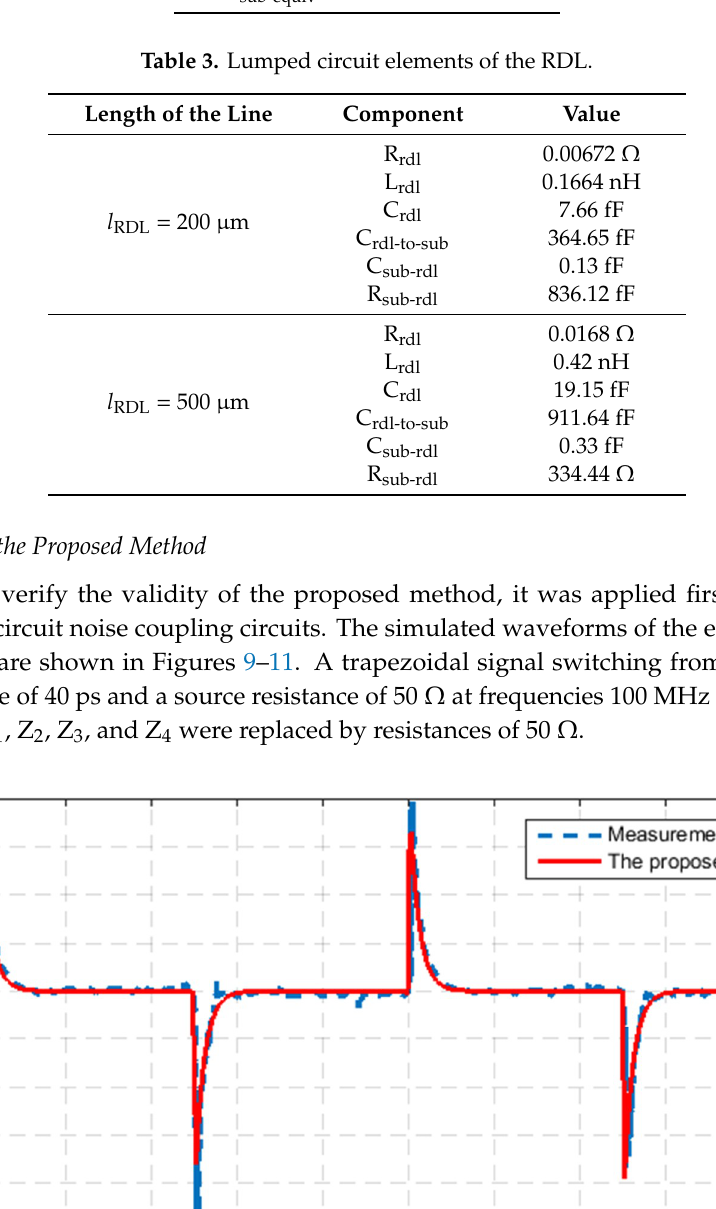
Table 2. Lumped circuit elements of TSV–active circuit noise coupling.